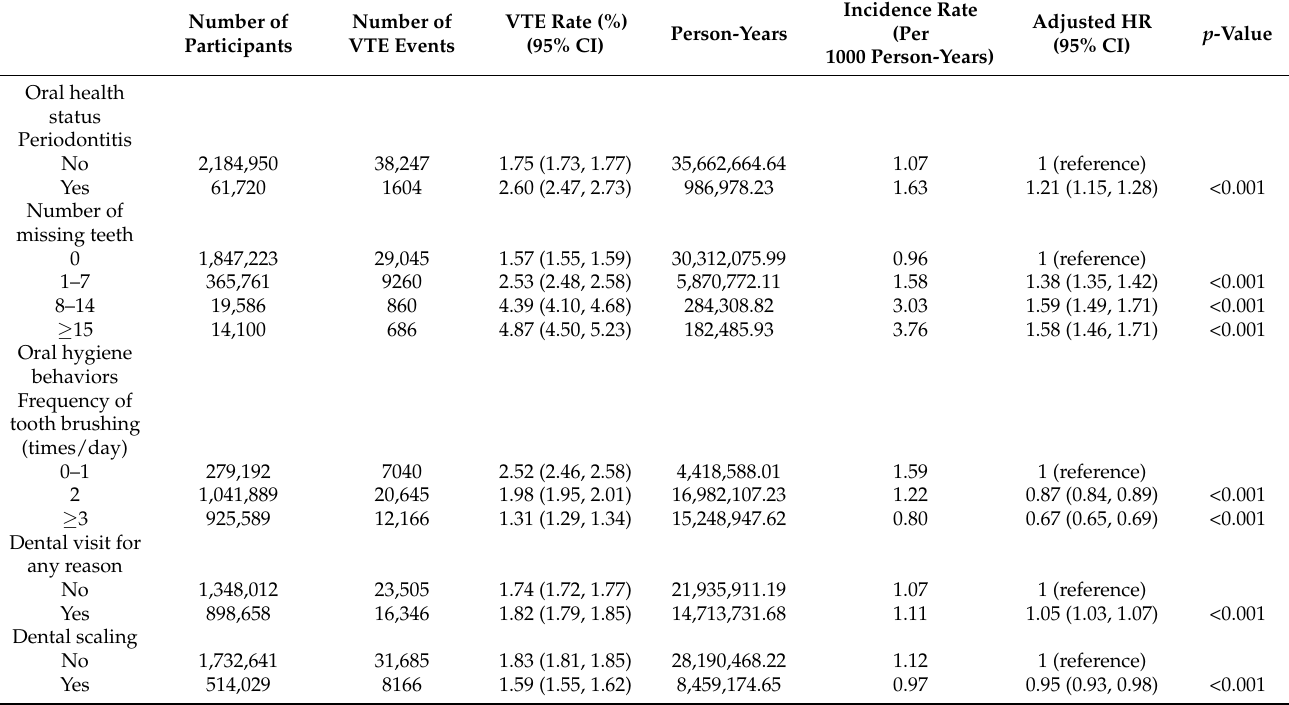
Table 2. The risk of venous thromboembolism according to oral health status and oral hygiene